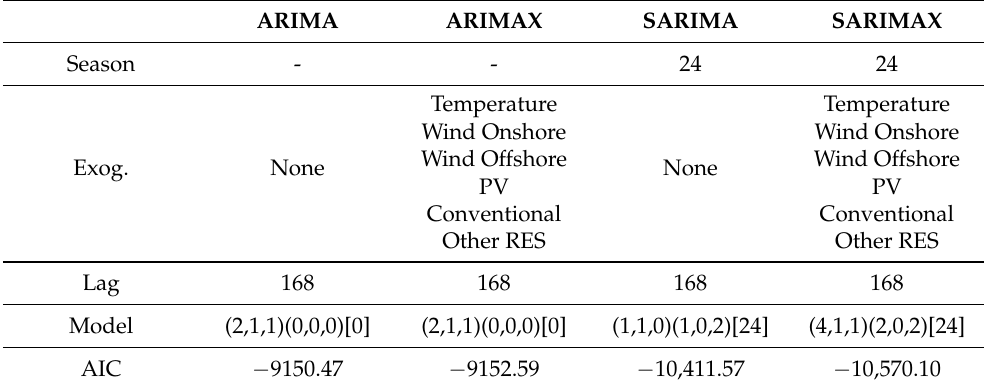
Table 3. Fitting ARIMA models.